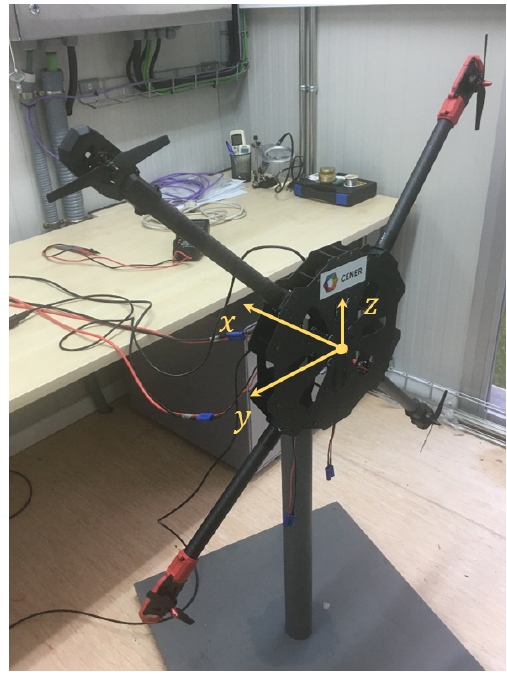
Figure 1. Multi-propeller actuator at the National Renewable En- ergy Centre (CENER) calibration workbench. Wind turbine thrust is applied in the x direction, and rotor moments M y and M z are applied on the y and z axis, respectively.